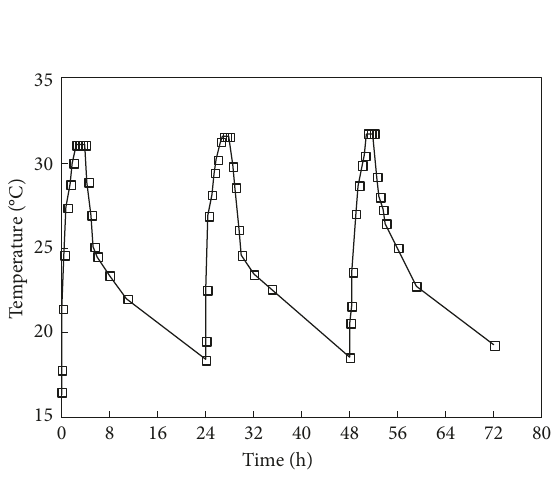
Figure 1: Experimental setup. Figure 3: Measured temperature variation of the pile.